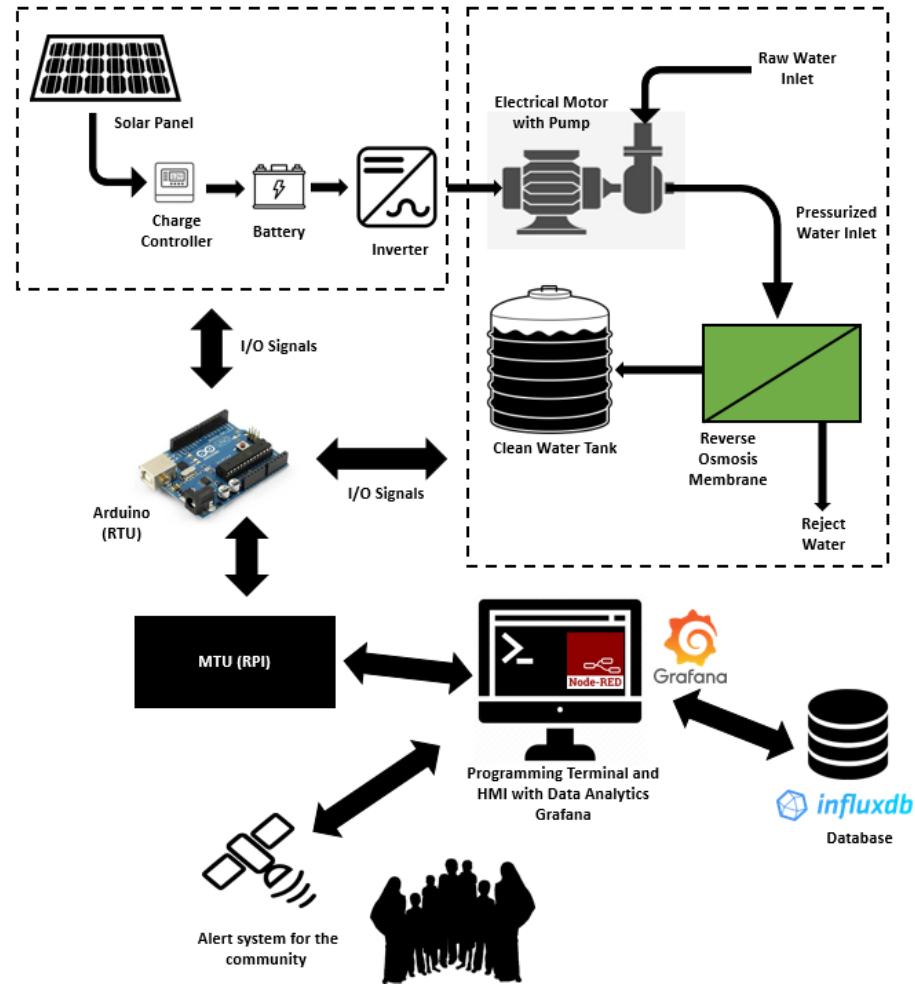
Figure 1. Proposed SCADA System for a Solar-powered Reverse Osmosis Desalination System Ar- chitecture.